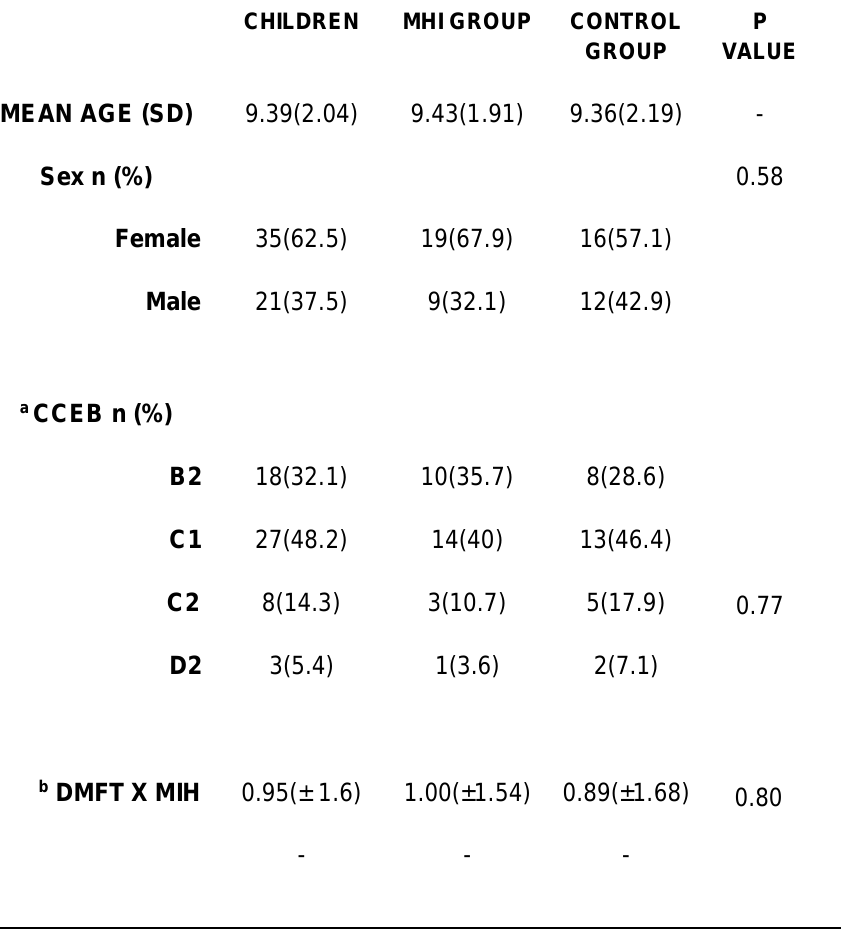
TABLE 1. CHARACTERISTICS OF THE